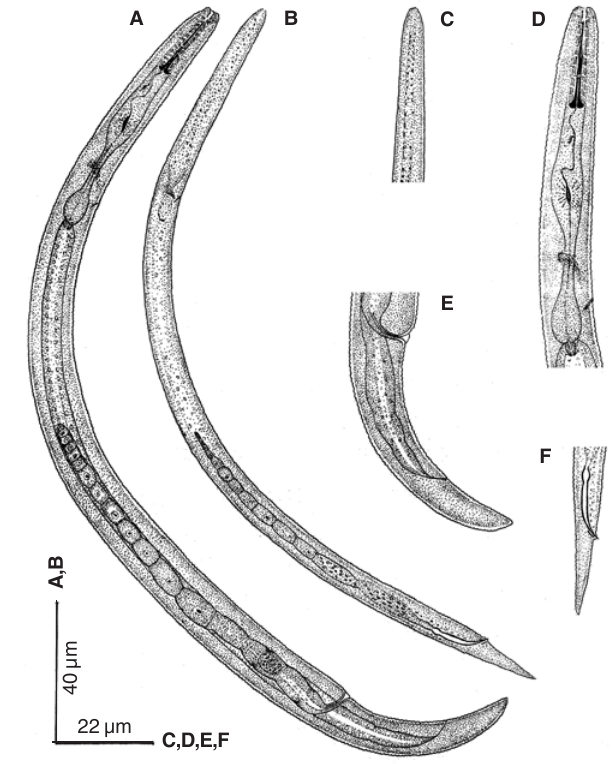
Figure 1. Paratylenchus thysanolus sp. nov. A - Female, entire body; B - Male, entire body; C - Male, anterior body; D - Female, anterior body; E - Female, tail region; F - Male, tail region.